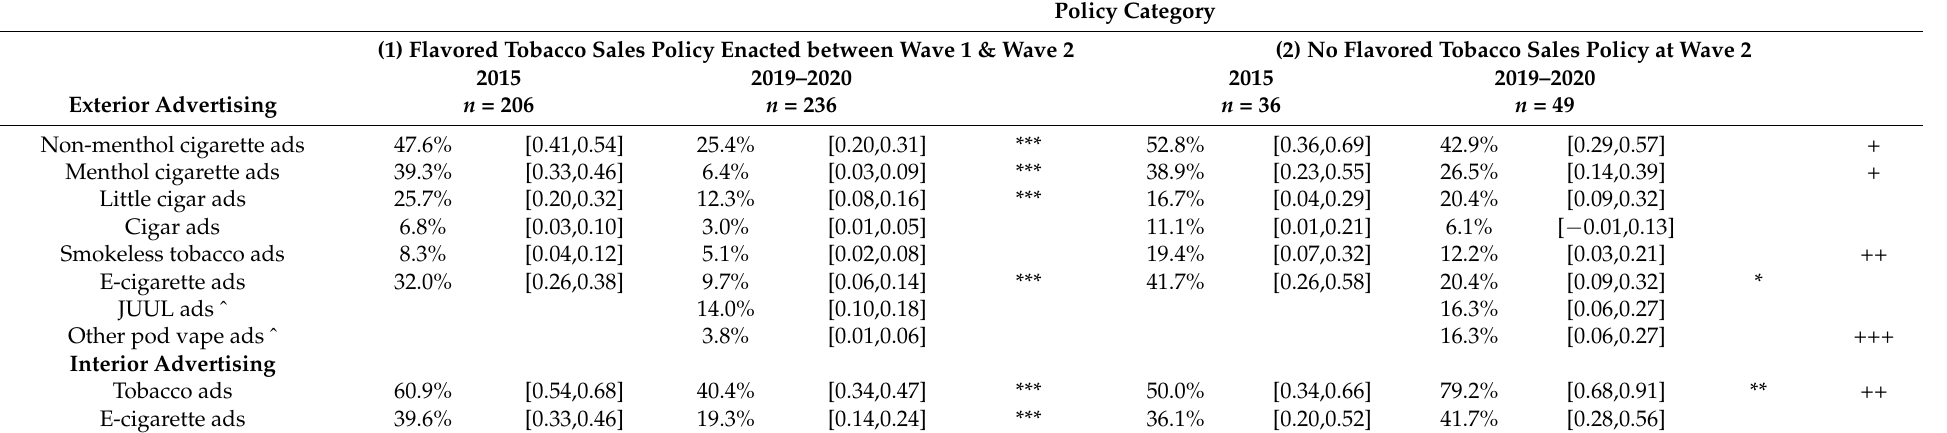
Table 2. Prevalence of flavored tobacco advertising in San Francisco Bay Area retail stores over time and by flavored tobacco sales policy category, 2014–2020 San Francisco Bay Area Young Adult Health